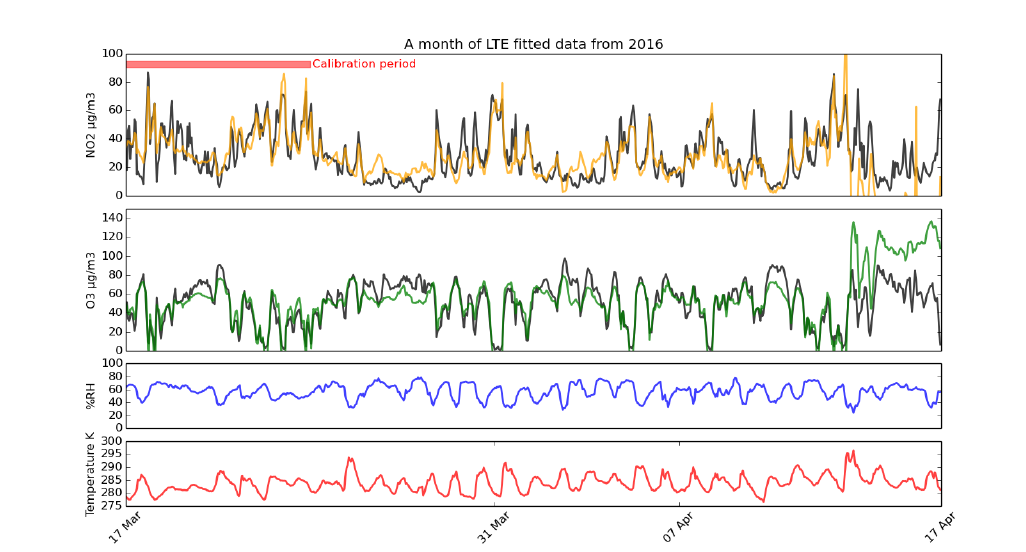
Figure 9. A typical month-long time series from the long-term experiment, with concentrations produced by fitting the sensor output using Equations (13) and (17) for NO (green) respectively to the AURN station data (black), over the calibration period highlighted in red. Temperature and humidity are also included, showing a clear diurnal